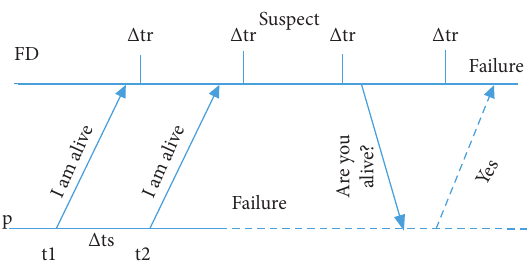
Figure 8: Push-pull failure detection